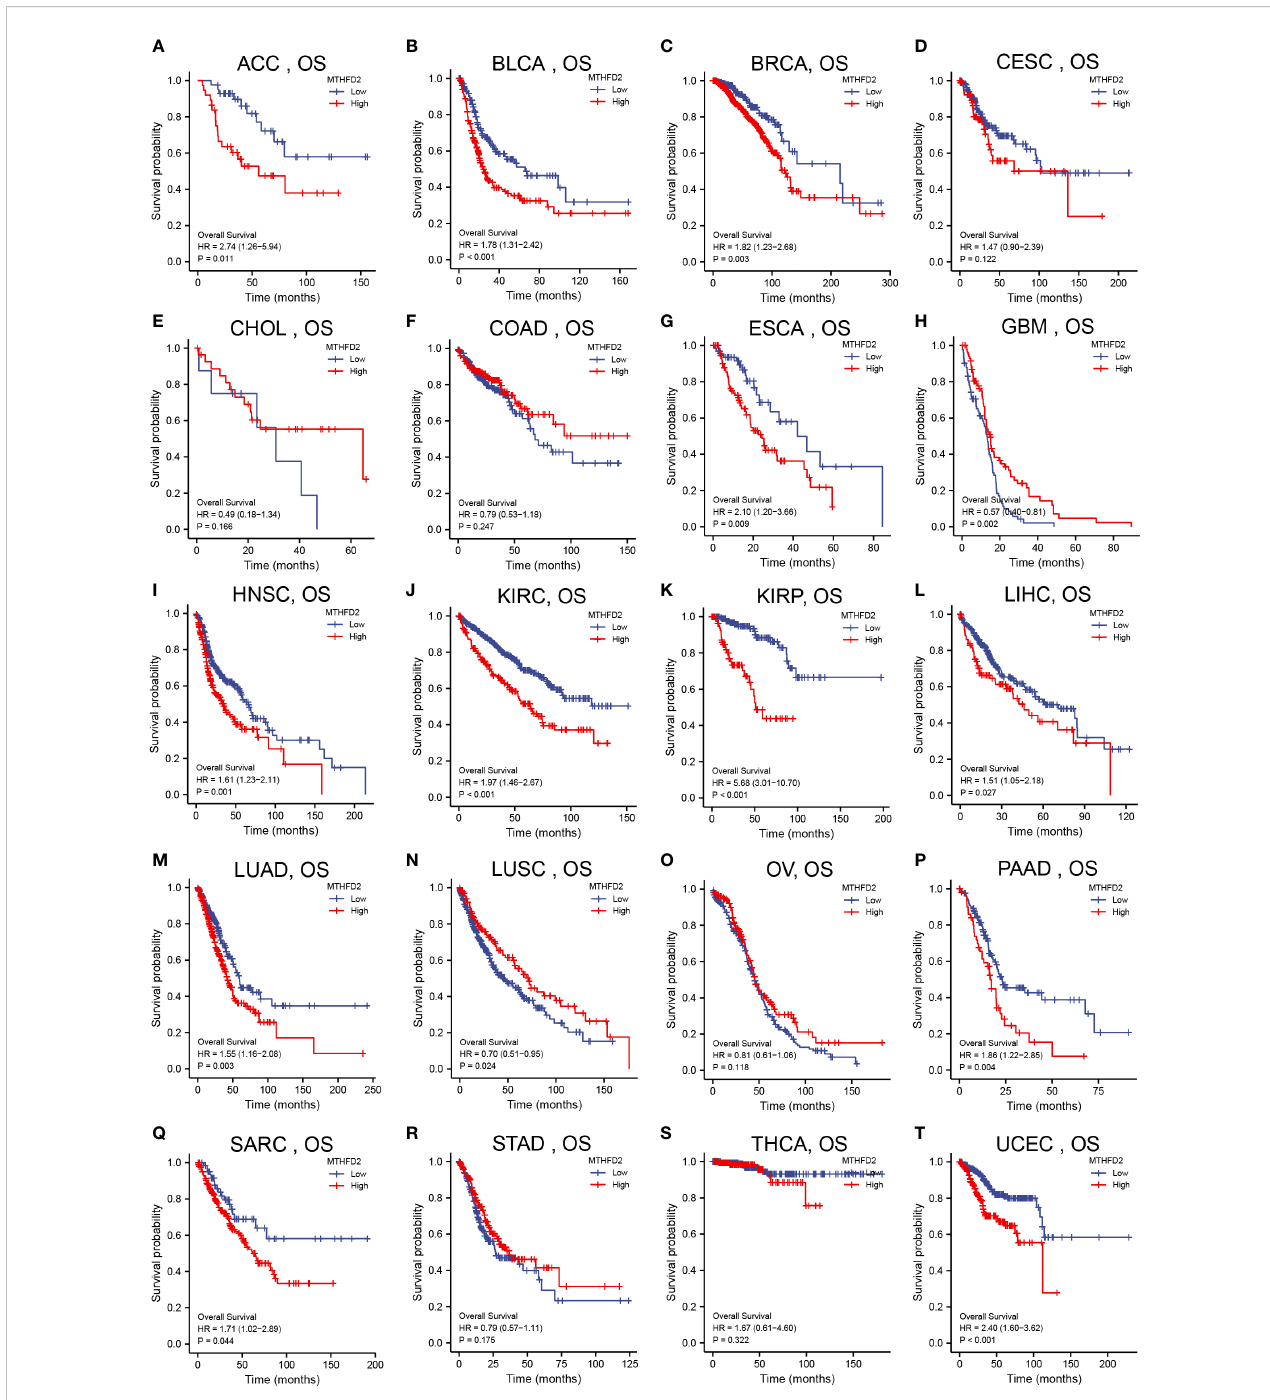
FIGURE 2 Pan-cancer patient survival analysis. Overall survival (OS) analysis of MTHFD2 in different tumors using Kaplan – Meier survival curves. (A) ACC, (B) BLCA, (C) BRCA, (D) CESC, (E) CHOL, (F) COAD, (G) ESCA, (H) GBM, (I) HNSC, (J) KIRC, (K) KIRP, (L) LIHC, (M) LUAD, (N) LUSC, (O) OV, (P) PAAD, (Q) SARC, (R) STAD, (S) THCA, (T) UCEC. Red lines indicate high MTHFD2 expression, while blue lines indicate low MTHFD2